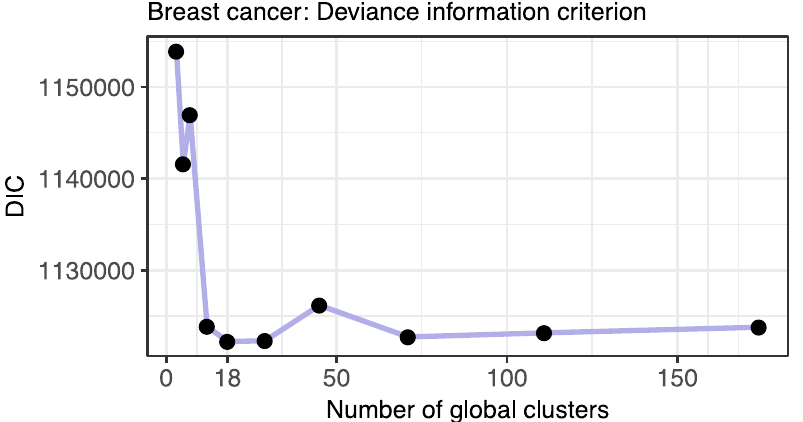
Fig 16. Devianceinformation criterion (DIC) as a method for selecting number of clusters. The plot shows the DIC for a range of numbers of globalclusters when the numberof local clusters is set to three. The DIC is minimizedfor 18